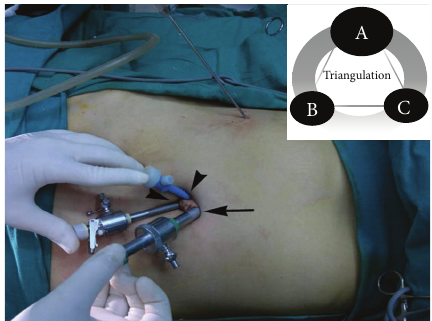
Figure 2: Port position. One 10mm (arrow) and two 5 mm (arrow heads) ports placed on the umbilical mound in triangular fashion ( Upper inset) . Note the port-closure needle at the right hypochon- drium for gallbladder